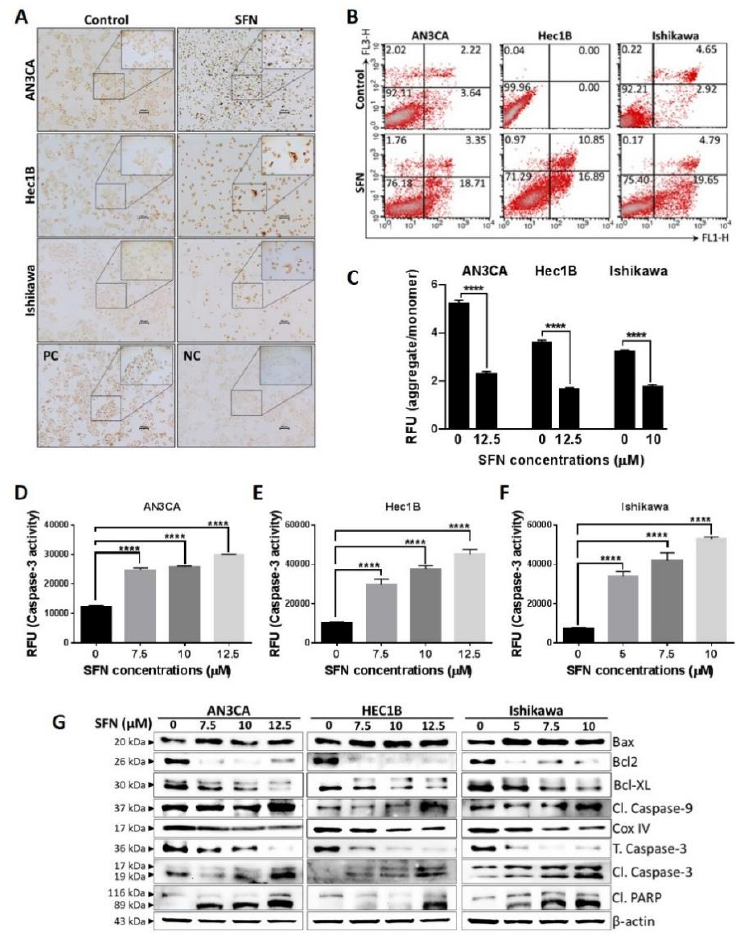
Figure 2. Sulforaphane induces mitochondrial-mediated apoptosis in endometrial cancer cells. ( A ) Endometrial cells were treated with sulforaphane (AN3CA and Hec1B-12.5 µM; Ishikawa-10 µM) for 24 h and TUNEL assay was performed. For positive and negative controls, AN3CA cells were used. Cisplatin (20 µM) was used for the positive control group. Representative images taken at 10× magnification are shown. ( B ) Endometrial cancer cells were treated with sulforaphane (AN3CA and Hec1B-12.5 µM; Ishikawa-10 µM) for 24 h, followed by Annexin V-FITC/PI staining, and the apoptotic rate was analyzed by flow cytometry. Representative images of flow cytometry result with or without sulforaphane were shown. ( C ) JC-1 assay was performed to measure mitochondrial membrane potential in endometrial cancer cells treated with or without sulforaphane for 24 h. A ratio of aggregate and monomer data is expressed as mean ± SD of three independent experiments performed in triplicate. Two-way ANOVA was used for statistical analysis. ( D – F ) Endometrial cancer cells were treated with the indicated concentrations of sulforaphane for 24 h, and cleaved caspase-3 level was quantified by a caspase-3 activity assay. Data are expressed as mean ± SD and a one-way ANOVA was used for statistical analysis. ( E , G ) Endometrial cancer cells were treated with sulforaphane for 24 h, and the expression of apoptotic protein and anti-apoptotic protein were determined by western blot. “ p ” values are indicated, **** p ≤ 0.0001 when compared with respective control. SFN; sulforaphane. The whole western blot images of Figures please find in Figure